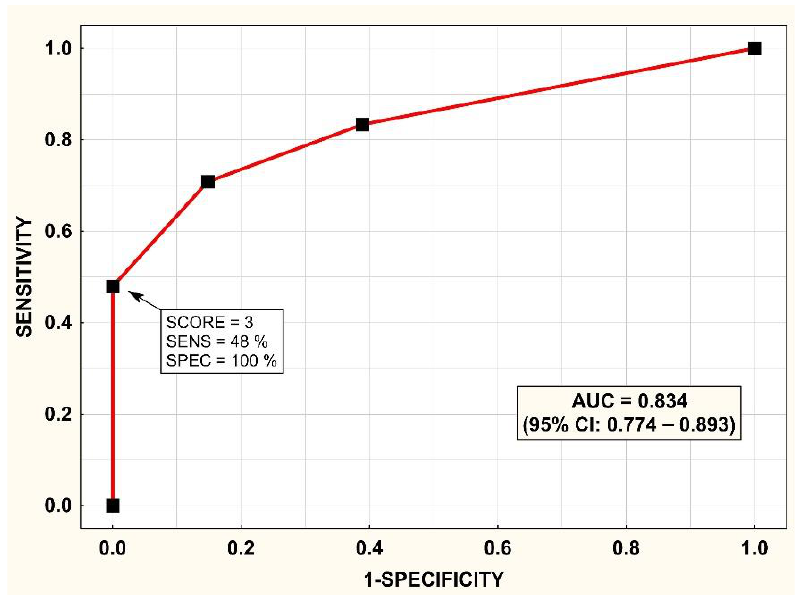
Figure 2. Prediction of unilateral primary aldosteronism (PA) in the development cohort: receiver operating characteristic (ROC) curve for the SCORE. AUC—area under the ROC curve; CI—confidence interval; PA—primary aldosteronism; PPV—positive predictive value; SENS—sensitivity.